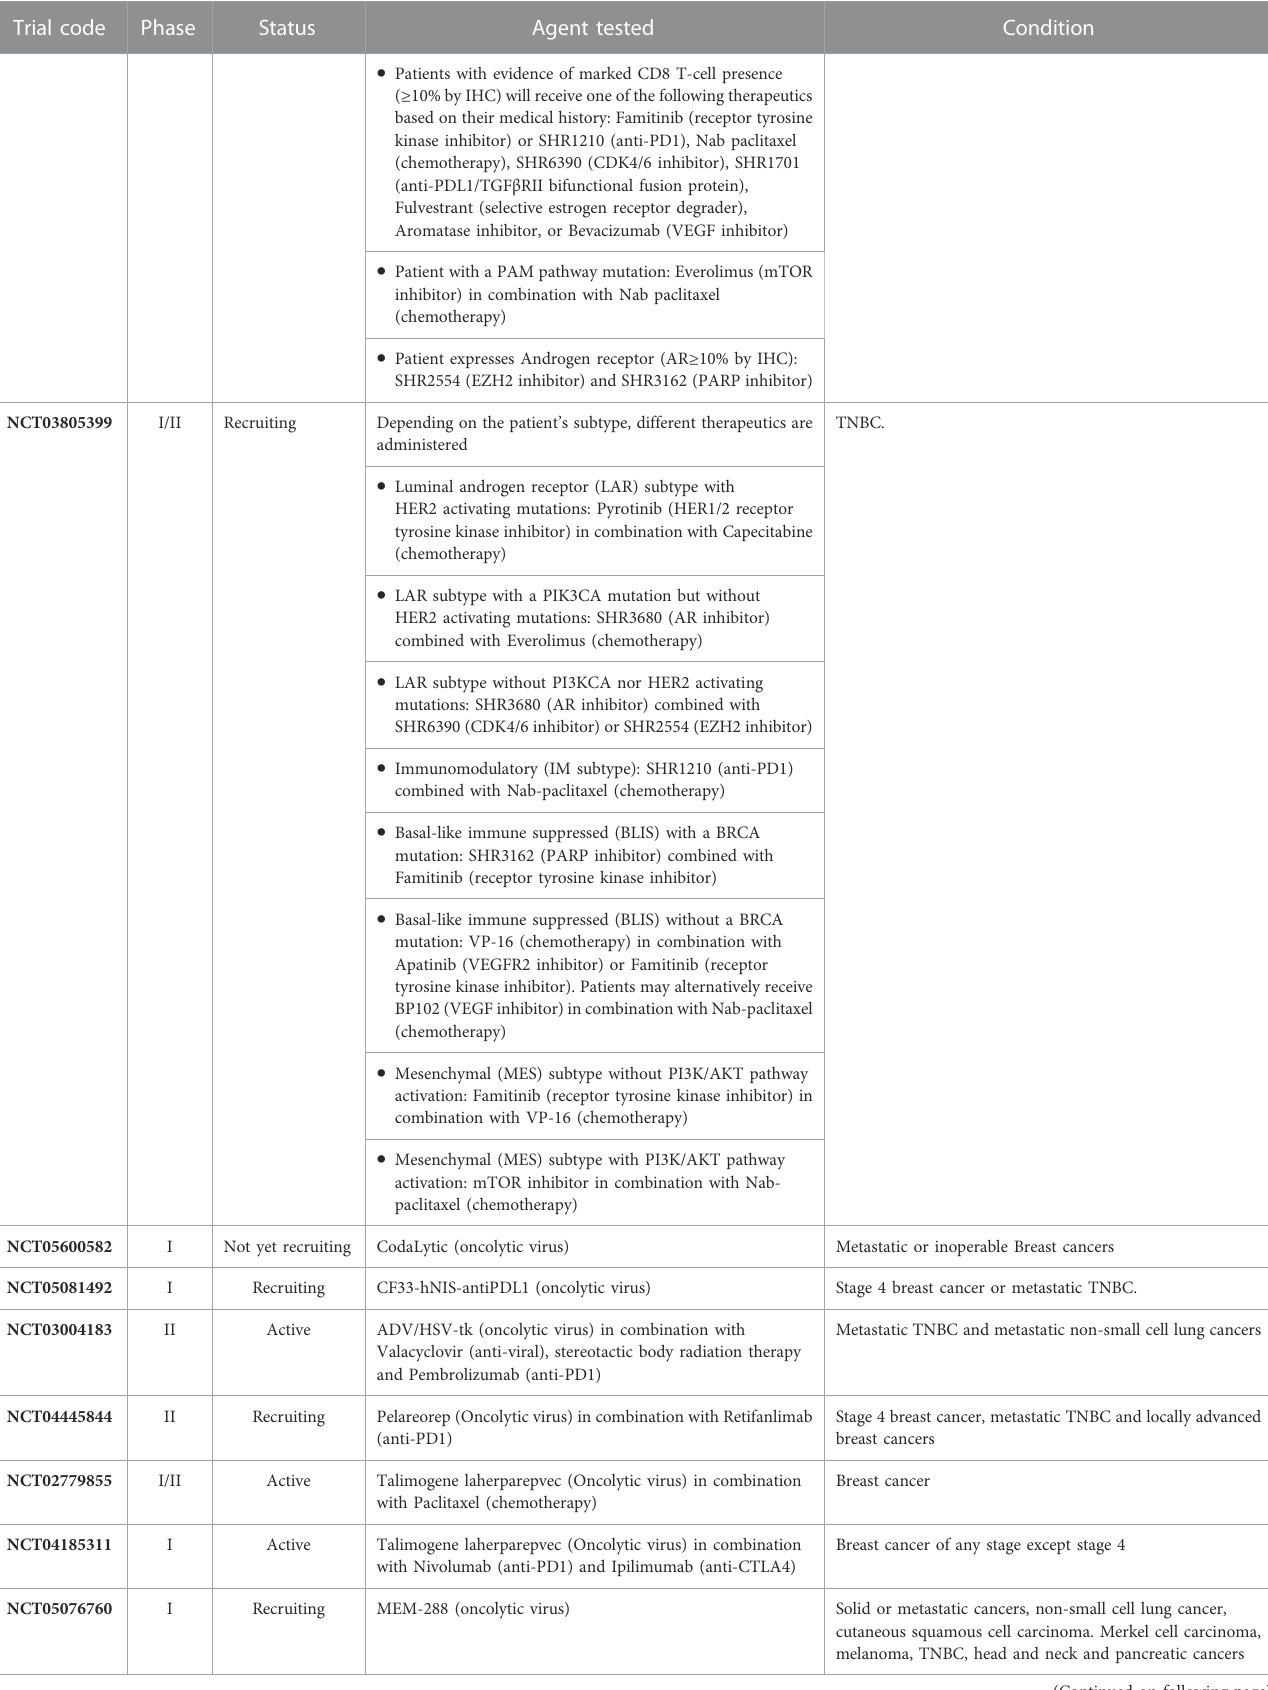
TABLE 1 ( Continued ) Summary of the clinical trials mentioned in this paper. Ordered based on appearance in the text. Trial